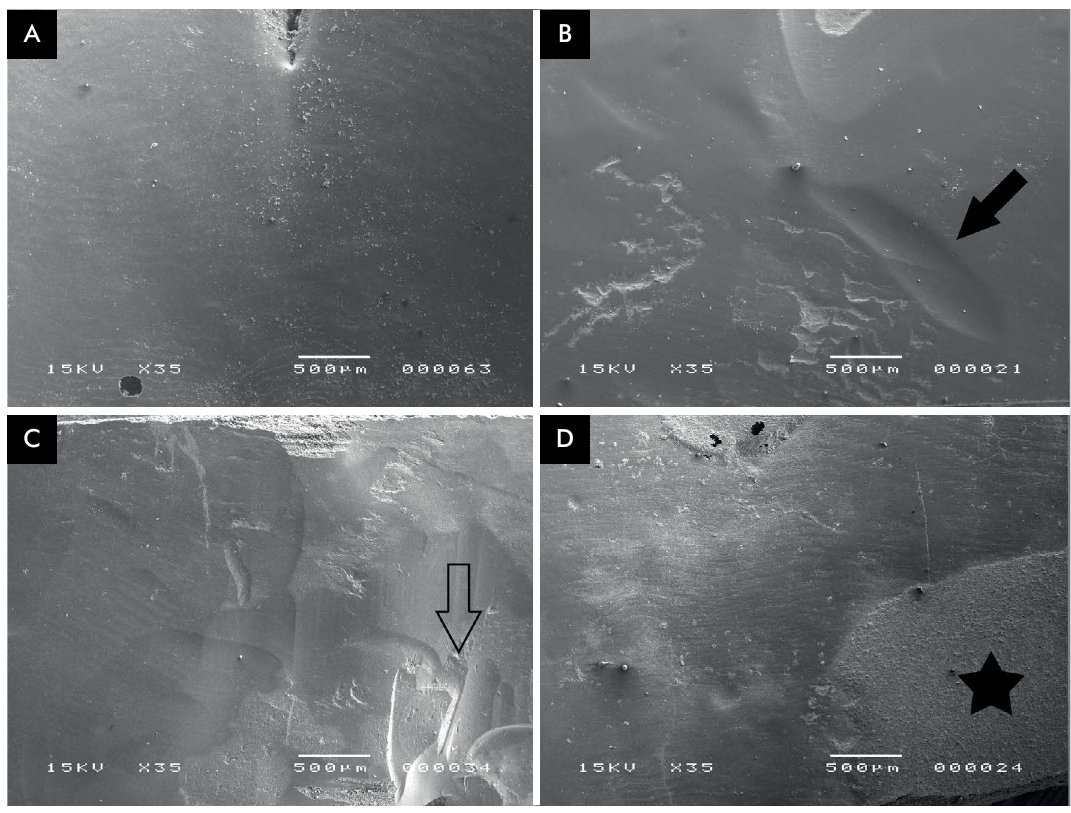
Figure 3. Criteria for scanning electron microscopy analysis to evaluate the appearance of enamel after removing adhesive remnants (35X magnification): a) intact dental enamel, absence of removal marks; b) dental enamel with the presence of soft removal marks (í); c) dental enamel with more evident removal marks ( ); d) dental enamel with the presence of adhesive remnants after removal ( ).